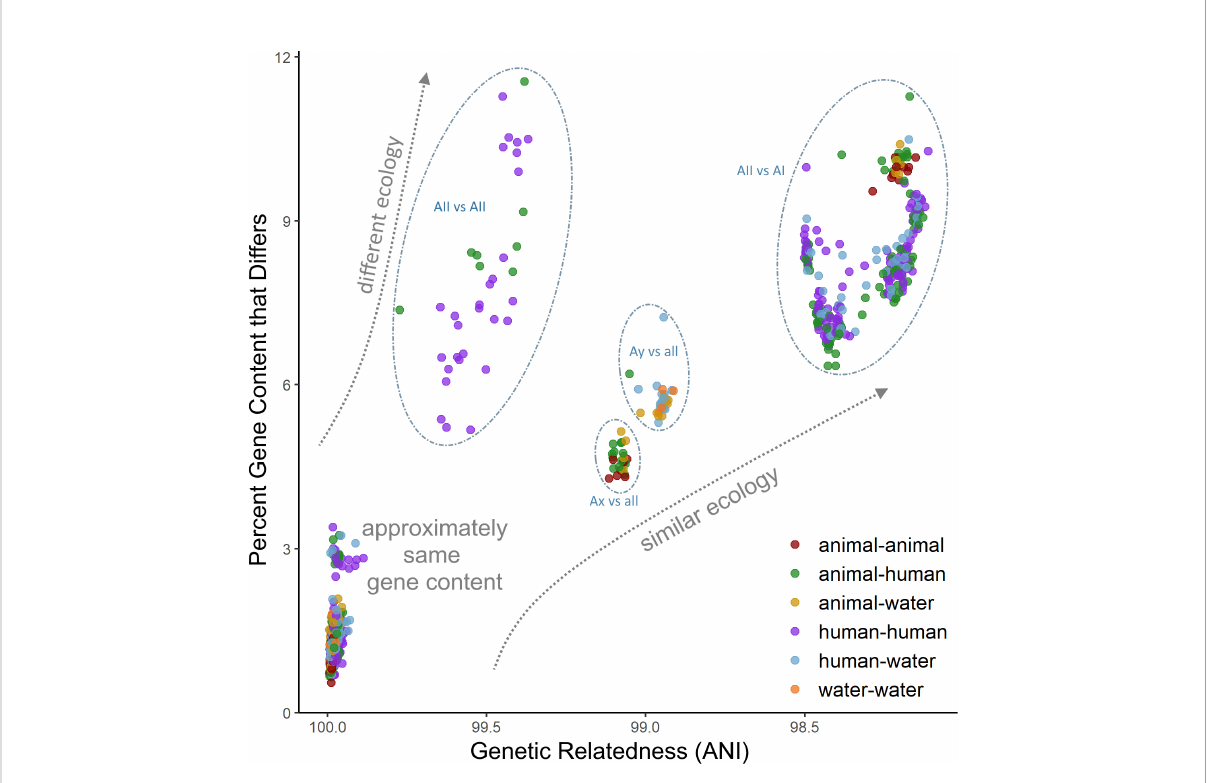
FIGURE 5 Comparison of gene content diversity with genomic relatedness. Each dot represents a pair of genomes. Dots are colored according to the host origin of the